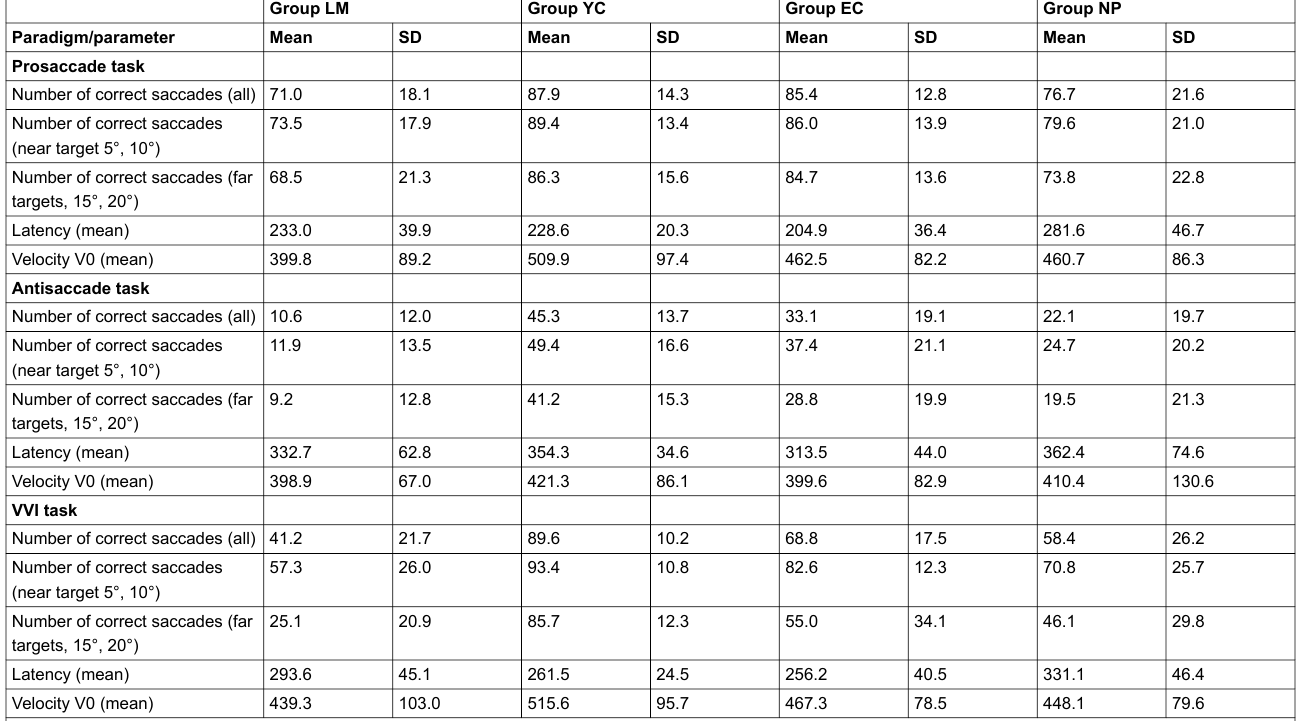
Table 3: Summary of the results. For all paradigms and all groups (LM, AC, EC, NP) mean and standard deviation (SD) are presented. Units are % for the number of correct saccades, ms for latency, °/s for velocity. Group LM Group